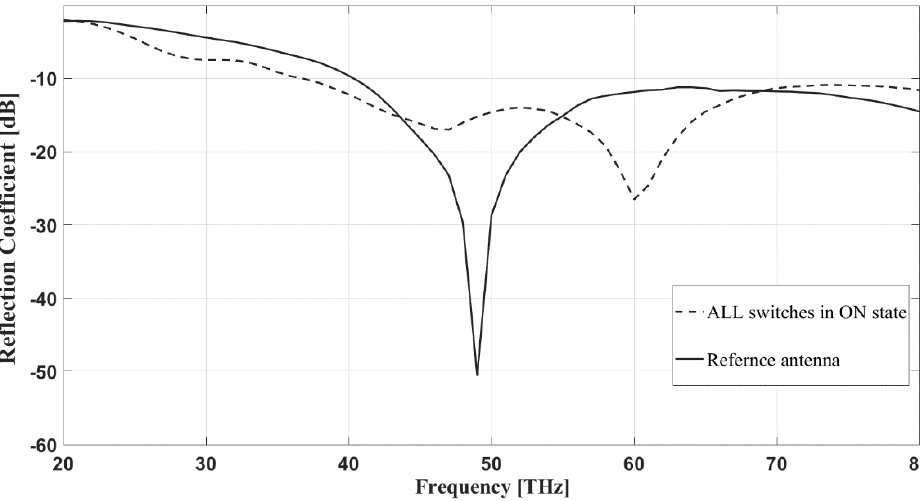
Figure 4. Reflection coefficients vs frequency in the case of the reference and pixel antennas. The simulations were done with the Sonnet Professional software.